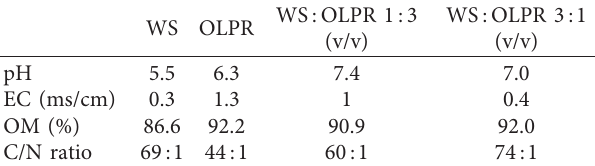
Table 1: Physicochemical properties of